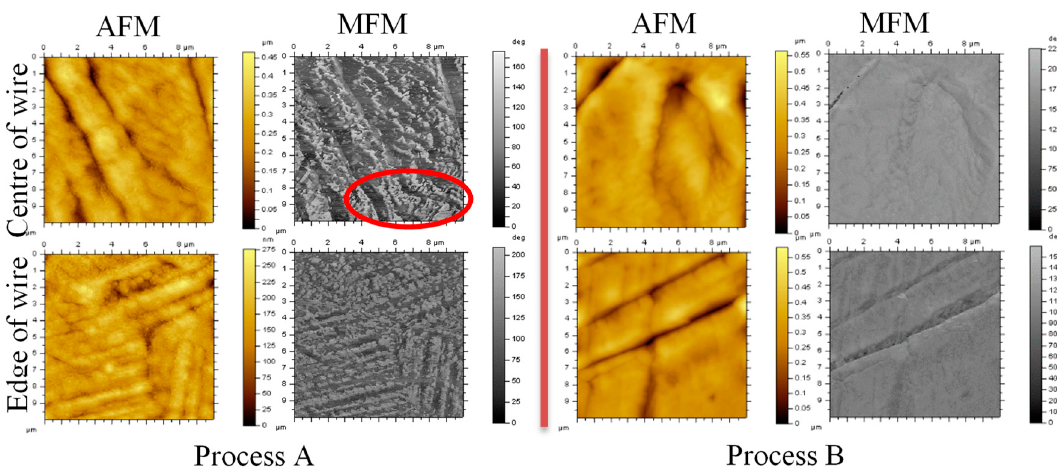
Figure 12. The AFM topography and MFM images of different region in base wire.